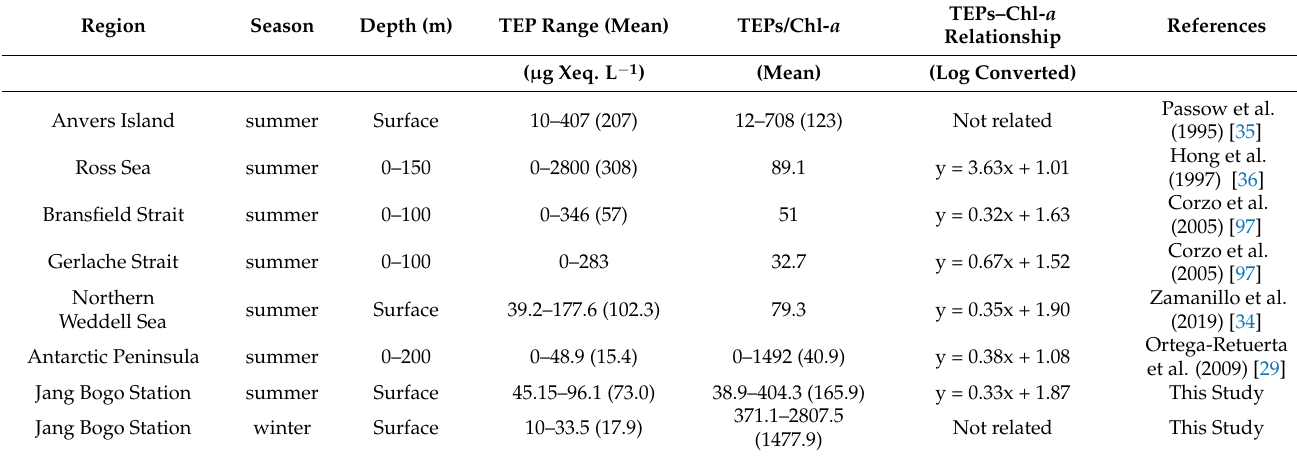
Table 2. Comparison of the TEP concentrations between this and previous studies from the Southern Ocean.